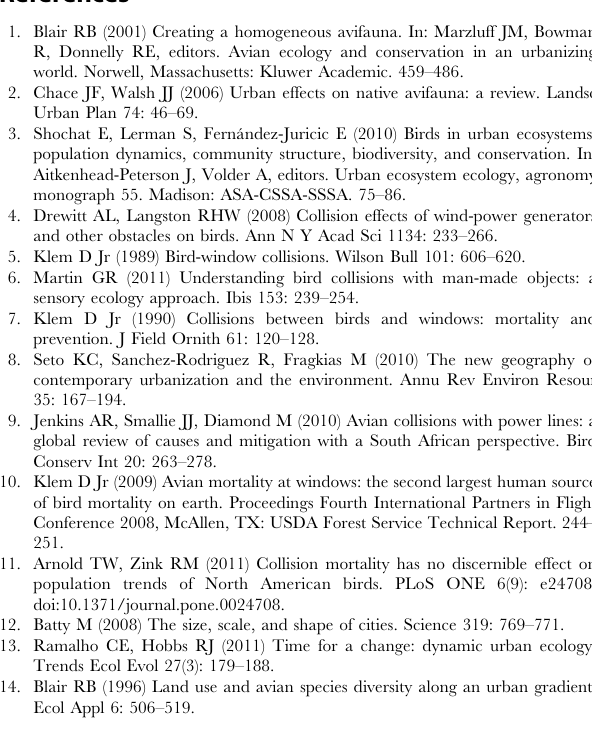
Figure S1 Relationship between carcass observability and mean ( ± 1 SE) detection probability of carcasses for two field workers at 20 buildings. Table S1 Most-supported models of carcass detection probability at 20 buildings in an urban landscape in Illinois, USA, 2010.